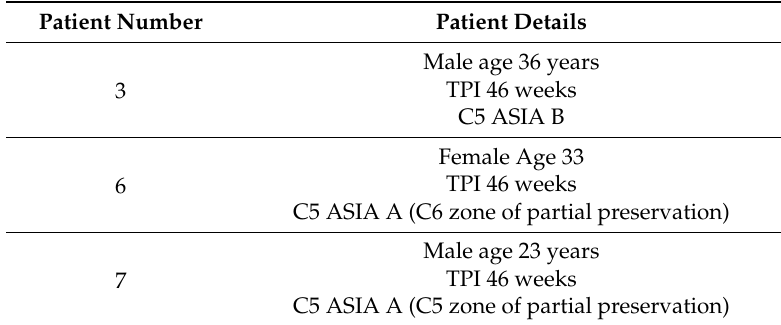
Table 1. Patient demographics.